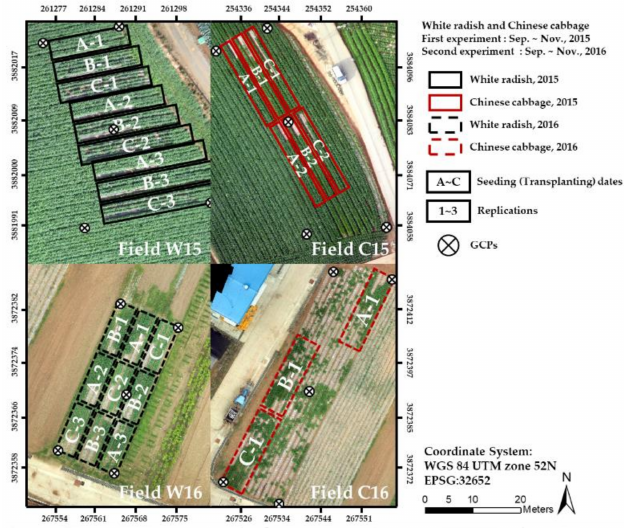
Figure 1. Test site: 2 years of Chinese cabbage and white radish